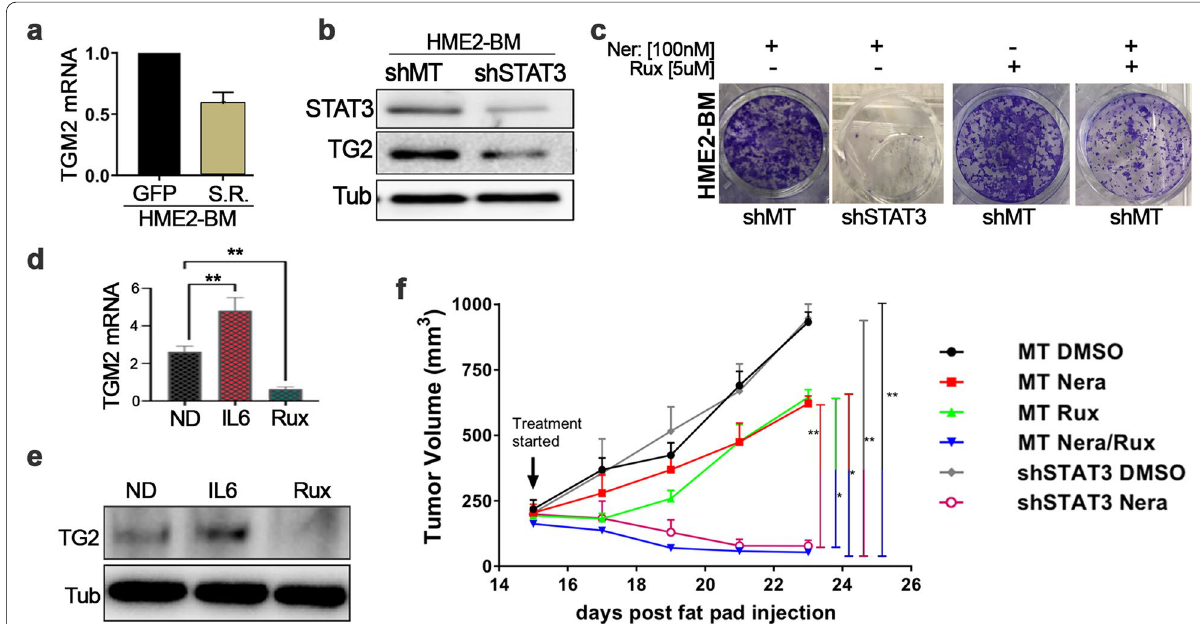
Fig. 5 STAT3-driven expression of transglutaminase-2 faciliates drug resistance. a Transcript levels for TG2 in HME2-BM cells expressing the NF-κB super repressor (S.R.) or GFP as a control were quantified using qRT-PCR. Data are relative to empty (MT) vector control (HME2-BM-MT) cells. b HME2-BM cells expressing a empty shRNA vectors (shMT) one those targeting STAT3 (shSTAT3) were analyzed for TG2 and STAT3. Analysis of β-tubulin served as a loading control. Immunoblots are representative of at least three independent experiments. c HME2-BM cells described in panel b were treated with neratinib, ruxolitinib, or both drugs every three days for a period of 5 weeks. Crystal violet staining was used at the indicated time points to visualize resistant cells. d HME2-BM cells were treated with no drug (ND) or cultured in the presence of IL-6 or ruxolitinib (Rux) for 14 days and expression of TGM2 was evaluated by RT-PCR. e Immunoblot results for TG2 from cells treated as described in (d), β-tubulin served as a loading control. f HME2-BM cells constructed as described in panel (a) were injected into the mammary fat pad and caliper measurements were used to quantify tumor growth. Arrow indicates initiation of neratinib or ruxolitinib or combination treatment. As a control mice were treated with an equal concentration of drug solvent (DMSO). Data are the mean SE of 5 mice per group resulting in the indicated ± p -values where * p < 0.05, ** p <